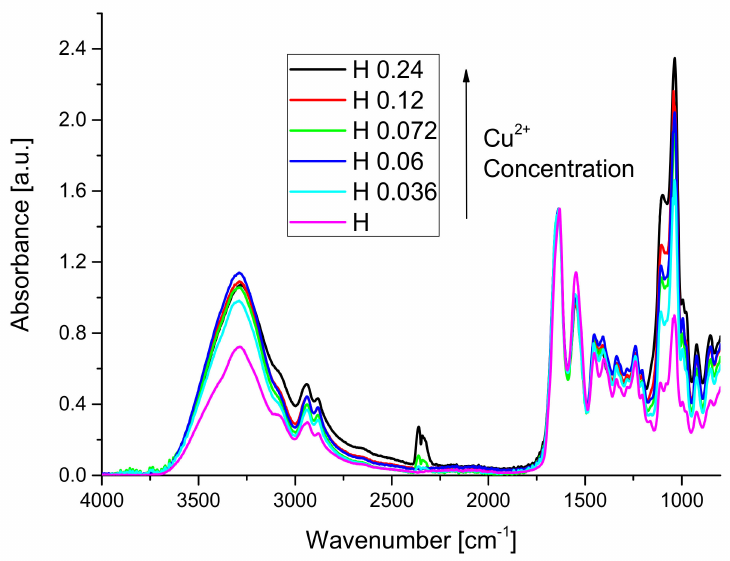
Figure 2. The influence of copper concentration on the FT-IR spectra of hydrogels.